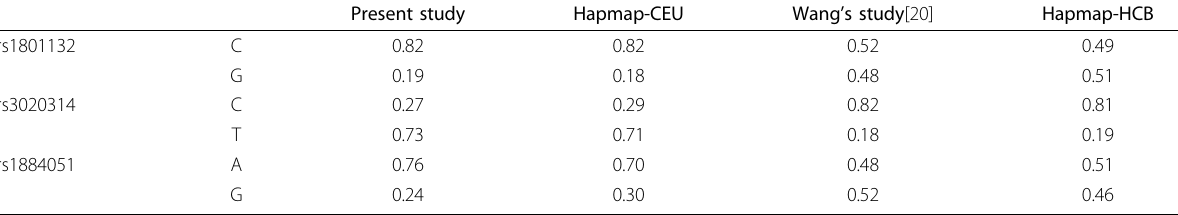
Table 2 Allelic frequencies in the present study and other Caucasian and Asian populations Present study